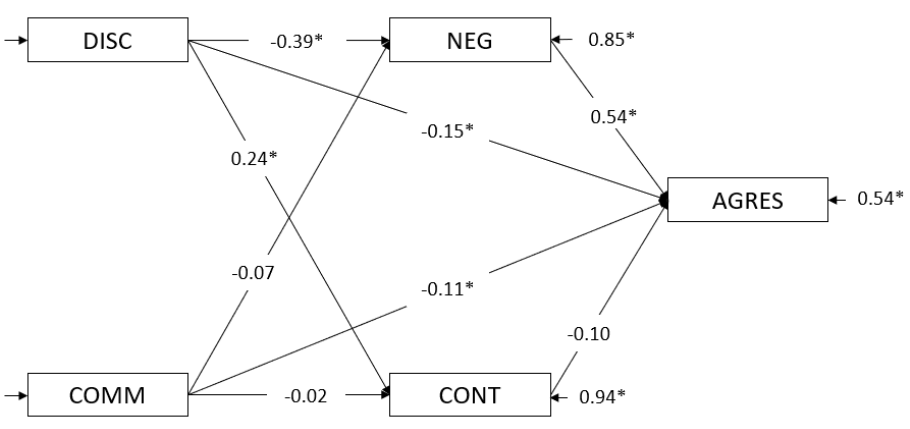
Figure 1. Mediational model for the 1–3-year-old group. Note: DISC = discipline; COMM